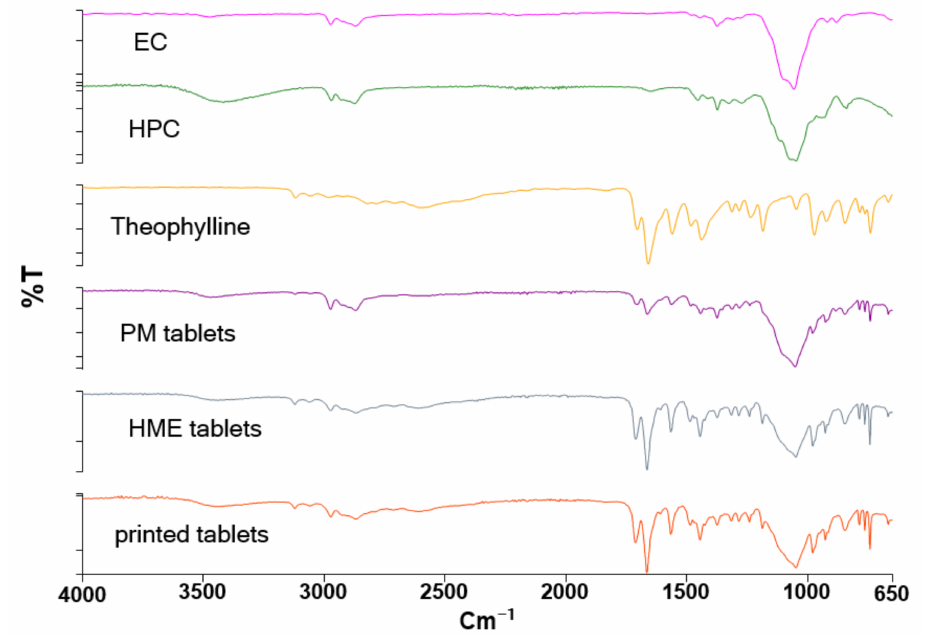
Figure 2. FTIR spectrum of F2 formulations obtained via different methods and raw